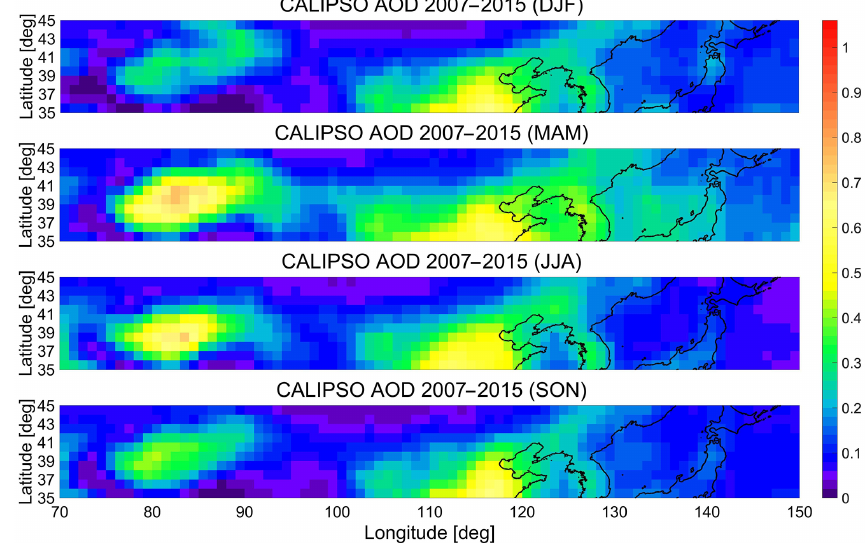
Figure 5. Seasonal maps of AOD at 532nm derived from CALIOP over the area 35–45 ◦ N, 70–150 ◦ E, including the Taklamakan/Gobi deserts and the Beijing–Tianjin–Hebei area, derived from 9 years of CALIPSO overpasses (2007–2015): winter (DJF), spring (MAM), summer (JJA) and autumn (SON).